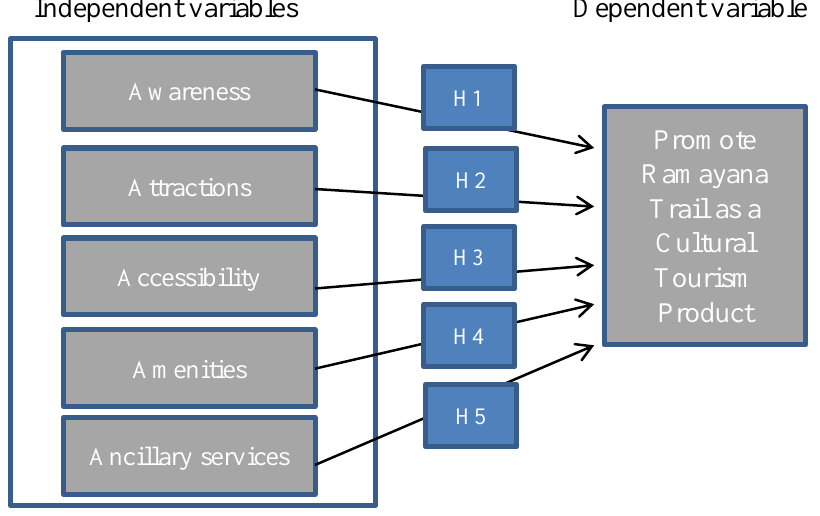
Fig. 01: Conceptual framework developed based on literature Hypothesis